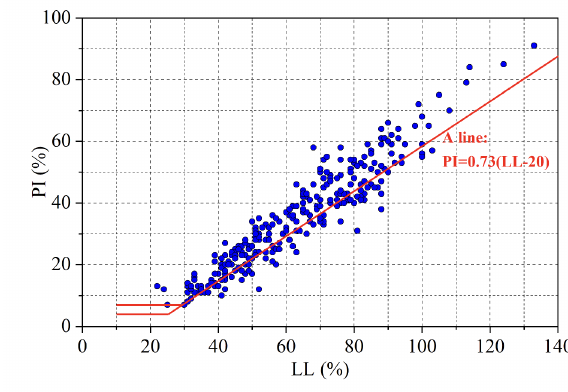
Fig. 2. Plasticity chart of soil mechanics